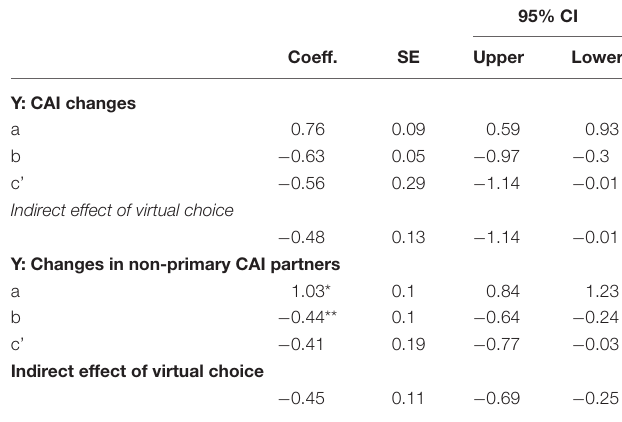
a,b,andc’correspondstothepathslegendin Figure 2 ,X:Identification,M:Safechoices, Y: real-life behavior changes (CAI and changes in Non-primary CAI partners). * p <